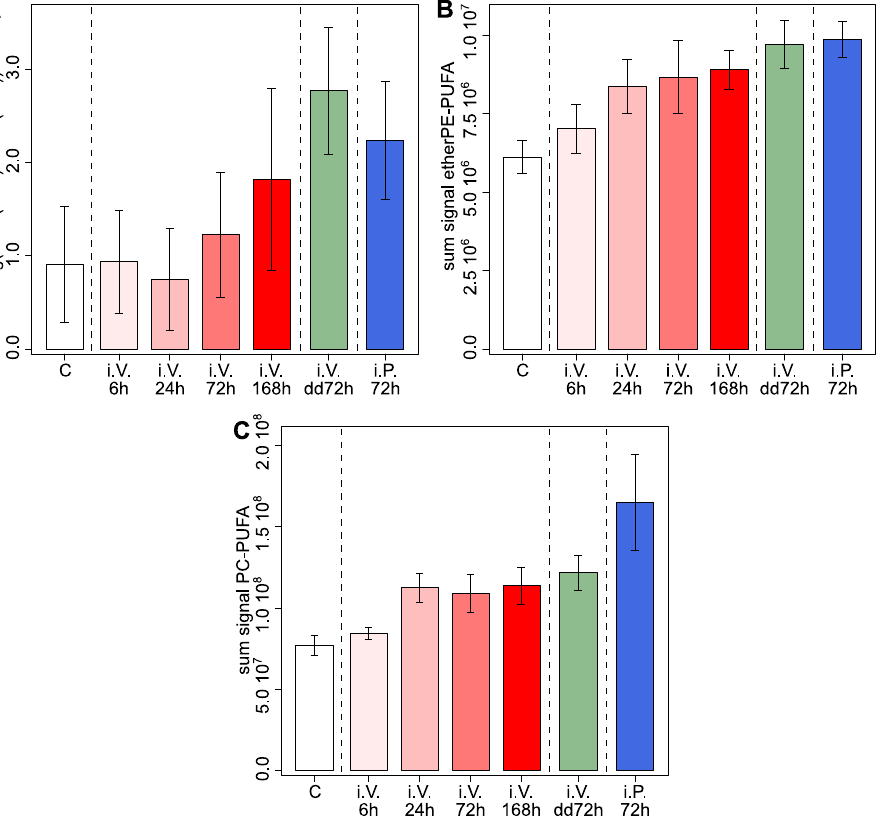
Figure 4. Effect of the treatment in the selected lipids in the jejunum. ( A ) Barplots of the effect of the treatments on the logarithm of the ratio between the sum triacylglycerols (TGs) and the sum of fatty acids (FAs) in the jejunum. ( B ) Barplots of the effect of the treatments on the sum of selected ether glycerophospholipids of ethanolamine with polyunsaturated fatty acids (etherPE − PUFA) in the je- junum. ( C ) Barplots of the effect of the treatments on the sum of selected phosphatidylcholines with polyunsaturated fatty acids (PC − PUFA) in the jejunum. In all cases, the barplots represent the aver- age and the whiskers represent the average plus/minus the standard error of the mean. dd, double dose; i.V., intra venous treatment; i.P., intra peritoneal treatment. 3. Concluding Remarks Our study confirms that ad libitum feeding scrambles the lipidome of the jejunum and the liver in vivo. Despite this effect, we found that DOX increased two families of lipids with PUFAs in the jejunum (etherPEs and PCs). Four different pieces of evidence support the independent regulation of the digestion status: (i) the loadings of these jejunal lipids were orthogonal (statistically independent) to the principal component dominated by the digestion (Figure 2A); (ii) these lipids were pathway consistent, as they contain PUFAs; (iii) the increase of lipids presented a gradual effect with the strength of the treat- ment (Figure 3); and (iv) the increase of lipids with PUFAs agrees with our previous re- sults in cell cultures, where the confounding of ad libitum feeding is absent [7]. In conclu- sion, this combination of facts strongly suggests that DOX increases PUFAs, which play a key role in the sensitivity of cells to ferroptosis [10].